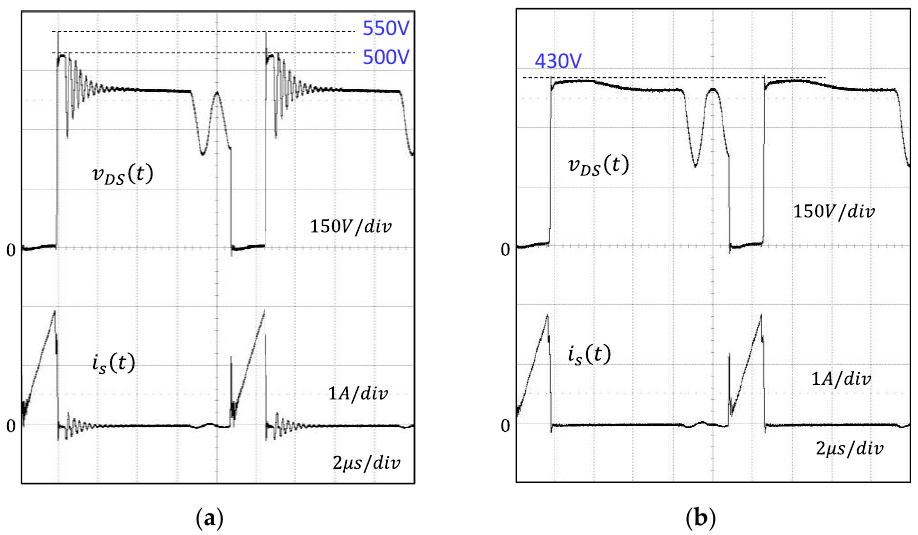
Figure 21. Comparison of steady-state switch voltage and current of QR flyback converter: ( a ) steady-state switch voltage and current waveforms of a QR flyback converter with RCD snubber; ( b ) steady-state switch voltage and current waveforms of a QR flyback converter with active snubber.